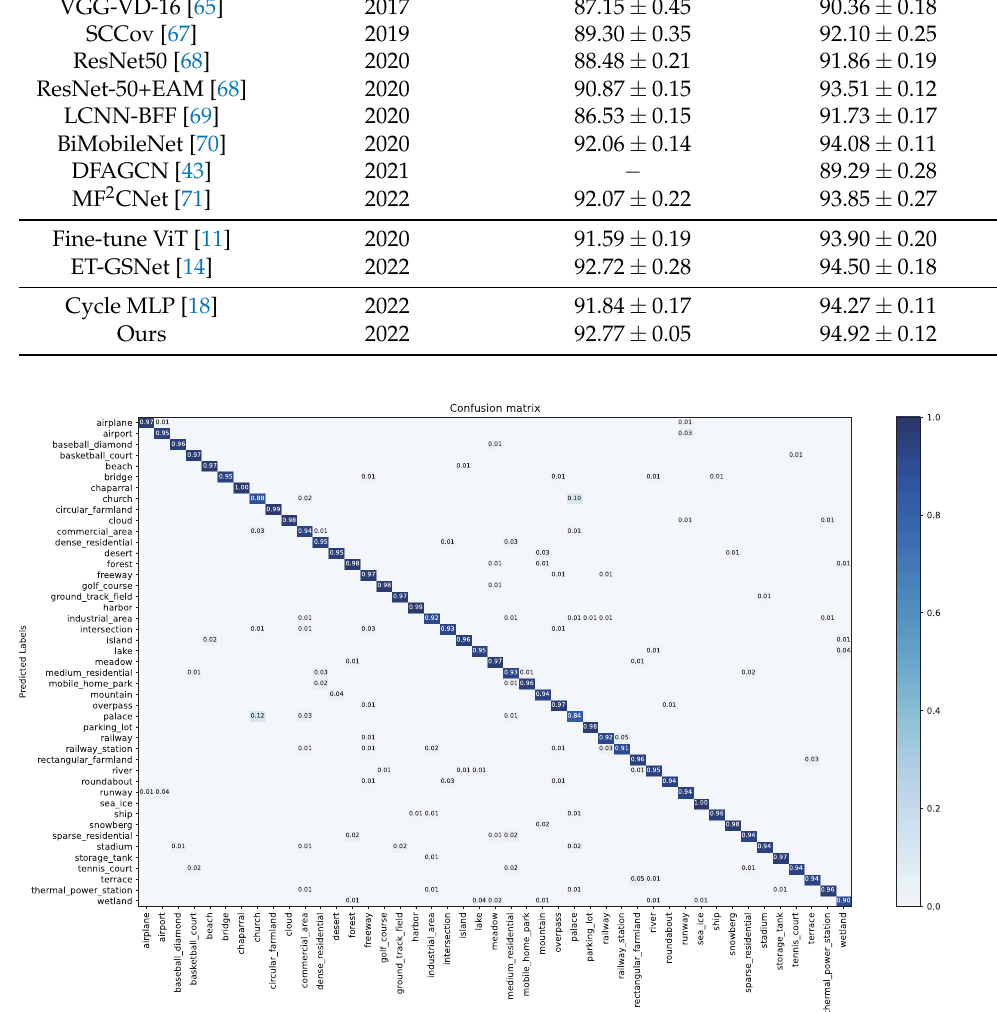
Figure 12. Confusion matrix on the NWPU dataset under the training ratio of